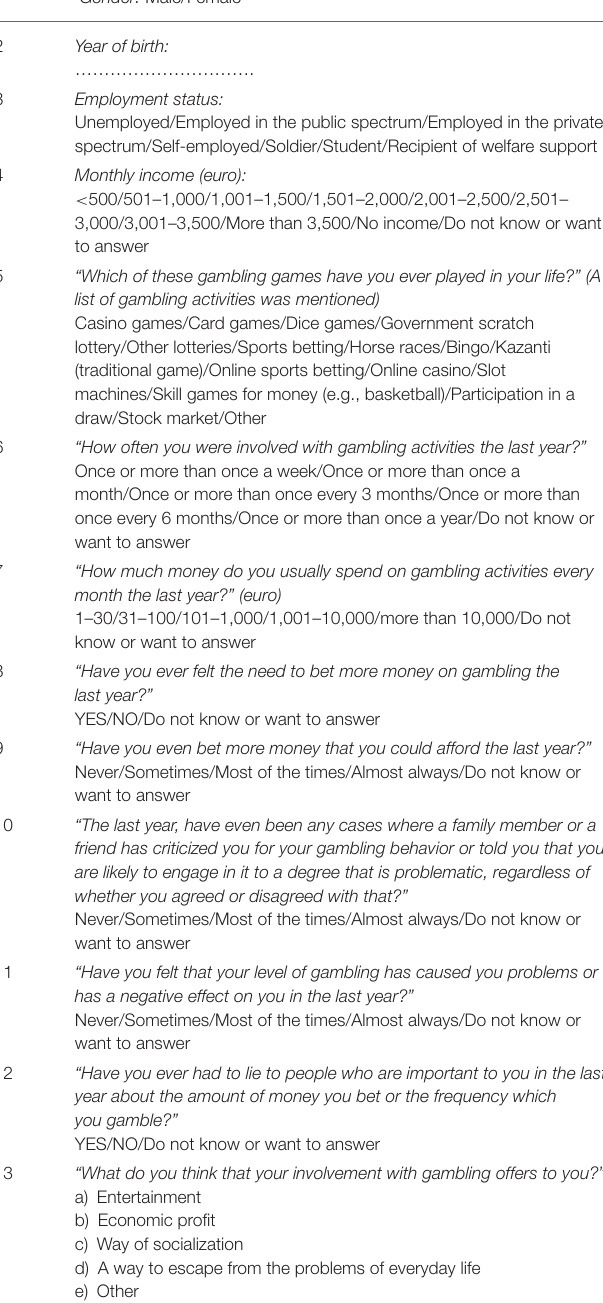
TABLE 1 | Screening questions and